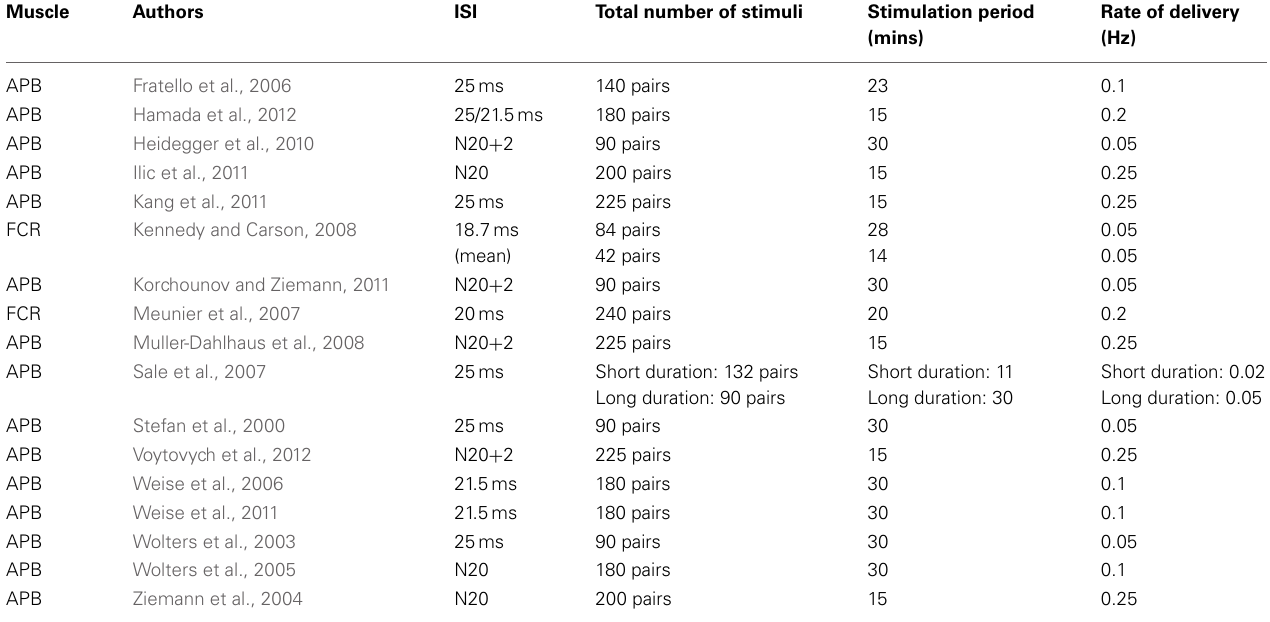
Table 1 | Upper limb muscles: excitatory